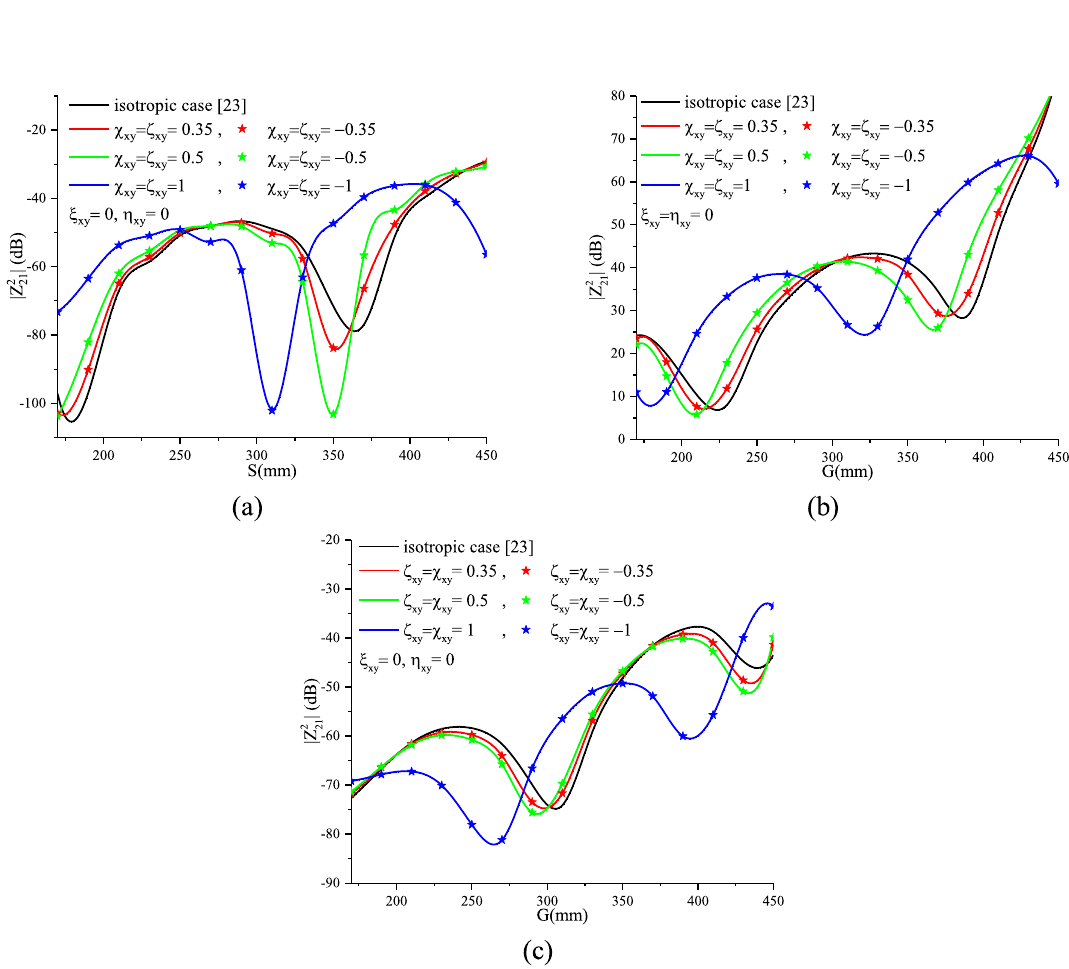
Figure 16. Tellegen effect on the mutual coupling of an ( a ) broadside, ( b ) collinear and ( c ) echelon surface wave modes are generated, resulting in further radiated power and more effect on parasitic elements in the vicinity of the dipoles 25 . The beneficial choice of the medium, that must be taken into account, is that of the chiral one. As it has been shown, this latter presents a decrease in coupling of more than 30% for certain values of S or G, on the other